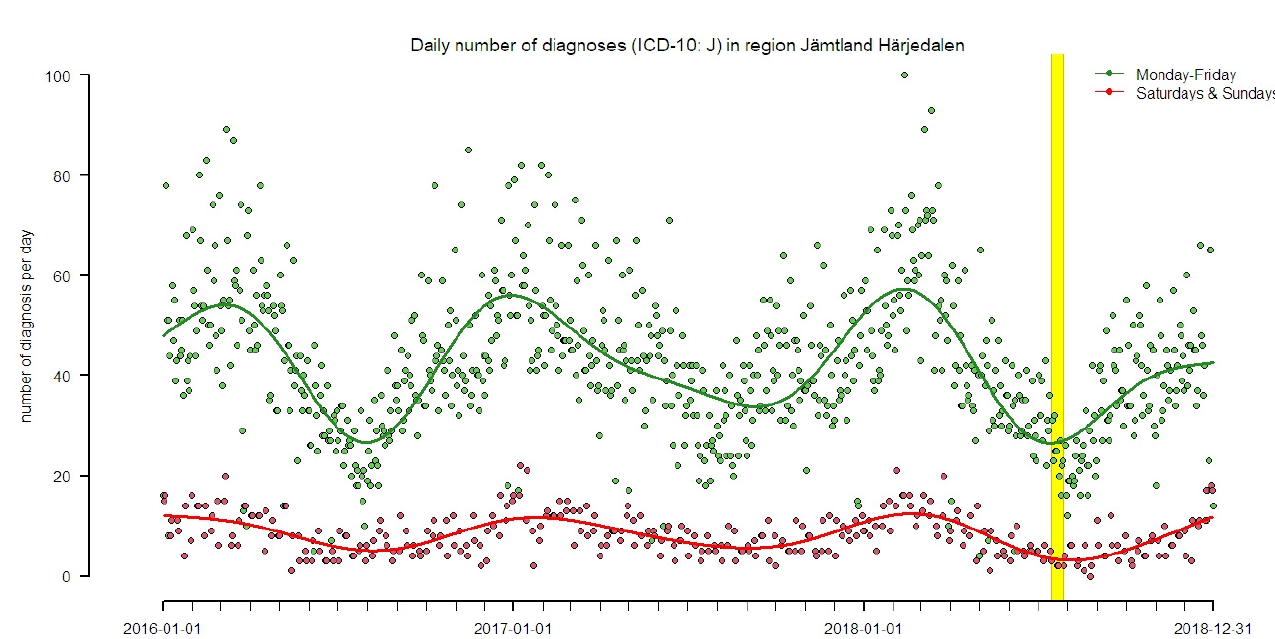
Figure 3. Daily number of acute visits for the diagnoses ICD-10: J for the population in Jämtland Härjedalen registered at healthcare centers in the region’s 8 municipalities, and at Östersund hospital. Data is separated by weekdays (green) and weekends (red) to illustrate the difference in frequency, and the yellow shading represents the time period were most of the wildfires occurred (15–28 of July 2018). Smooth spline functions with 4 degrees of freedom per year illustrates long-term trends (green and red lines).